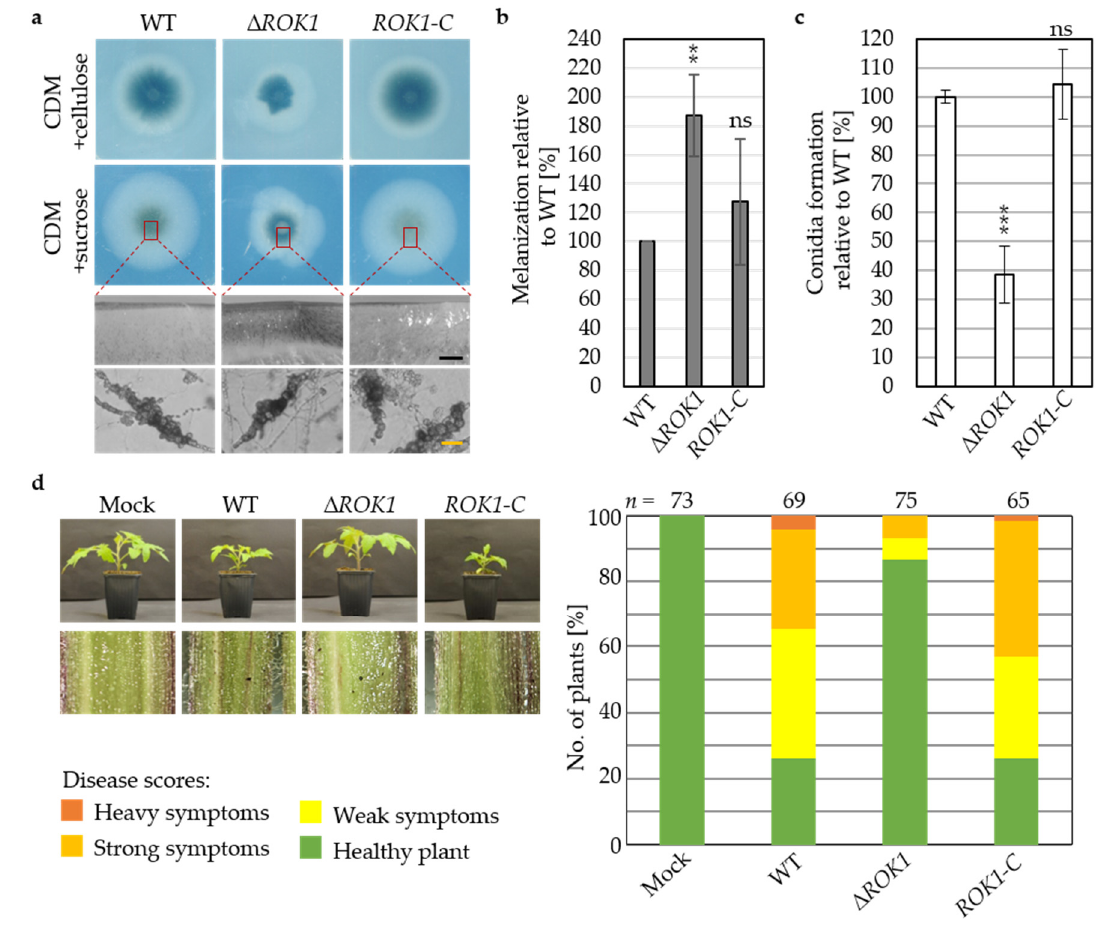
Figure 8. The Verticillium dahliae MAPK phosphatase Rok1 reduces microsclerotia formation and positively controls fungal growth and conidiation. The ROK1 deletion strain ( ∆ ROK1 ) was compared to wildtype (WT) and complementation strain ( ROK1-C ). ( a ) Vegetative growth and melanization ex planta. Phenotypes were examined 10 d after spot inoculation of 50,000 freshly harvested spores on CDM with either sucrose or cellulose and incubation at 25 °C. Colony center cross-sections (red boxes/dashed lines) and microscopy of scraped fungal material are shown for colonies grown on CDM with sucrose (black scale bar = 200 µm, yellow scale bar = 20 µm). ( b ) Melanization of colonies 10 d after spot inoculation on CDM with sucrose. ∆ ROK1 displays an increase in melanization about 80% relative to wildtype. Mean values of three independent experiments relative to wildtype with standard deviations are shown (significant difference to wildtype: ** p < 0.01; ns = non-significant, n = 3). ( c ) Quantification of conidiation in ∆ ROK1 . ∆ ROK1 conidiation 5 d post inoculation of liquid simulated xylem is reduced to about 60% relative to wildtype. Mean values of three independent experiments relative to wildtype with standard deviations are shown (significant differences to wildtype: *** p < 0.001, ns = non-significant, n = 3). ( d ) Pathogenicity test of ROK1 deletion and complementation strains towards Solanum lycopersicum . Representative plants and hypocotyl dissections 21 d after root dipping into distilled water as control (Mock) or the same numbers of spores obtained from different strains are shown (Scale bar = 1 mm). The stack diagram represents the relative number of plants with certain disease scores (total number of evaluated plants = n ). ∆ ROK1 induces less severe hypocotyl discolorations and overall disease symptoms in only 14% of treated